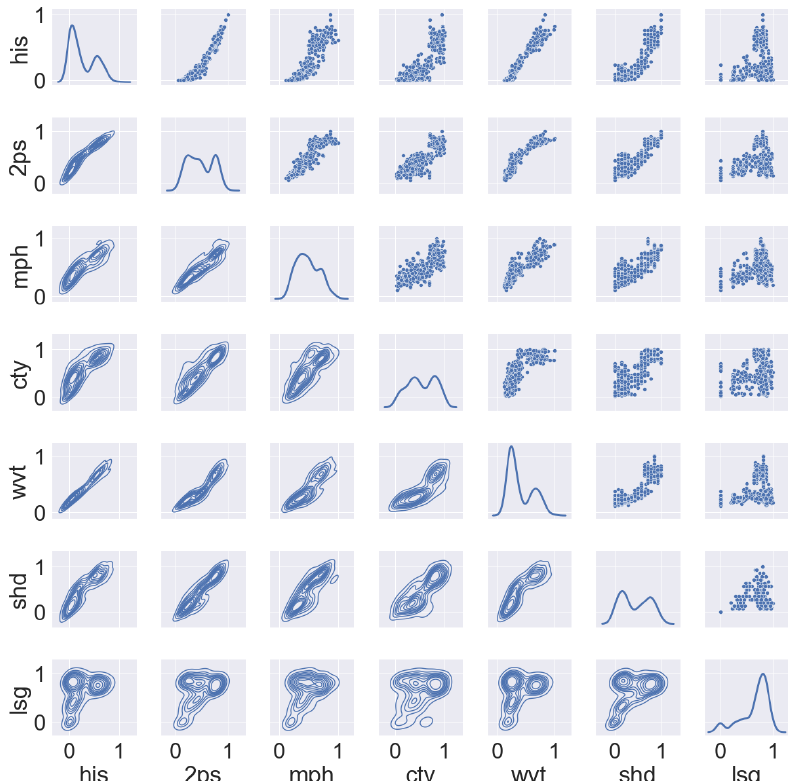
Figure 17. Comparison of global normalised dissimilarity measures for an ensemble of 30 lithocode 3D voxets across the 3 scenarios; cross- plots and density plots by pair of normalised dissimilarity measures; his – histogram, 2ps – semi-variogram, mph – multiple-point histogram, cty – connectivity, wvt – wavelet decomposition coefficients, shd – topological structural Hamming distance, lsg – topological Laplacian spectral